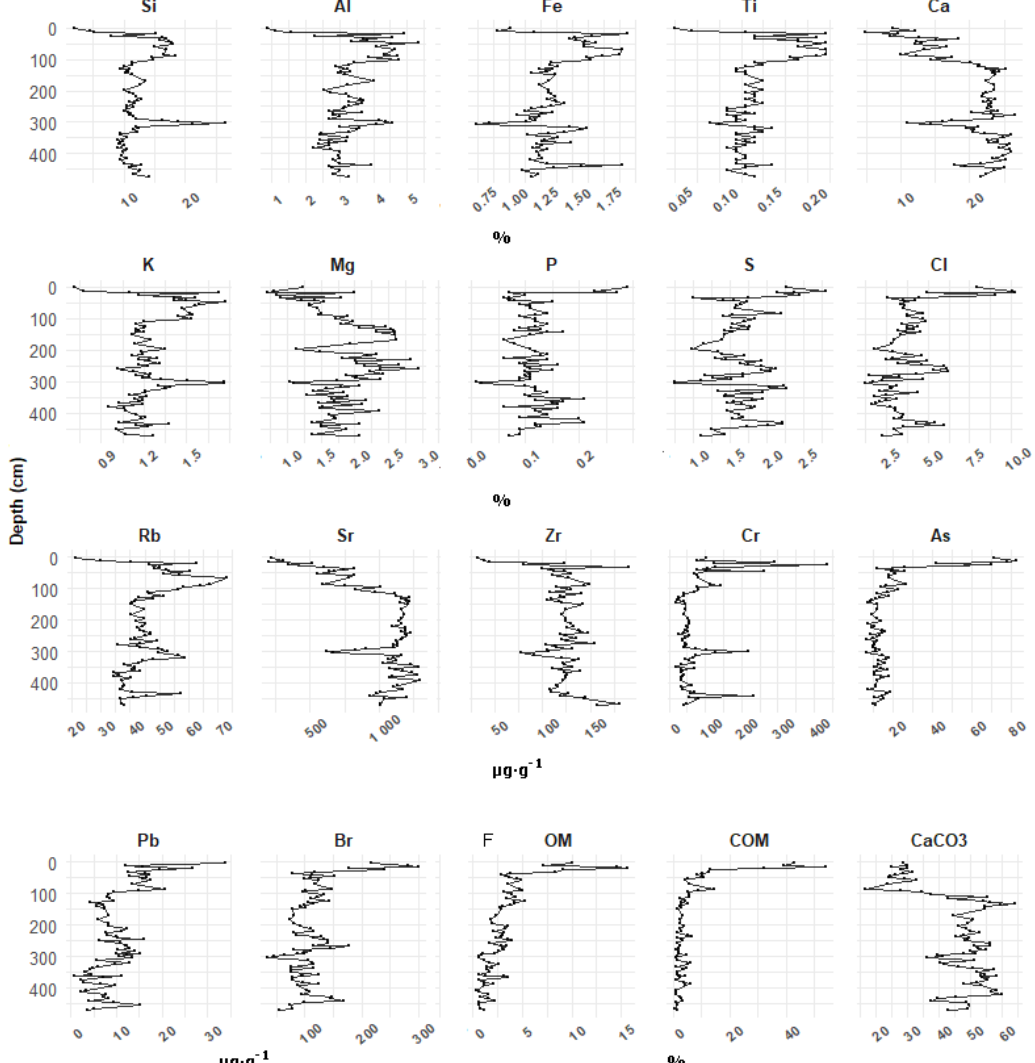
Figure 2. Major and minor elements (Si, Al, Fe, Ti, Ca, K, Mg, P, S and Cl), trace elements (Rb, Sr, Zr, Cr, As, Pb and Br), fine organic matter (FOM), coarse organic matter (COM) and carbonate concentration along the P. oceanica core studied.